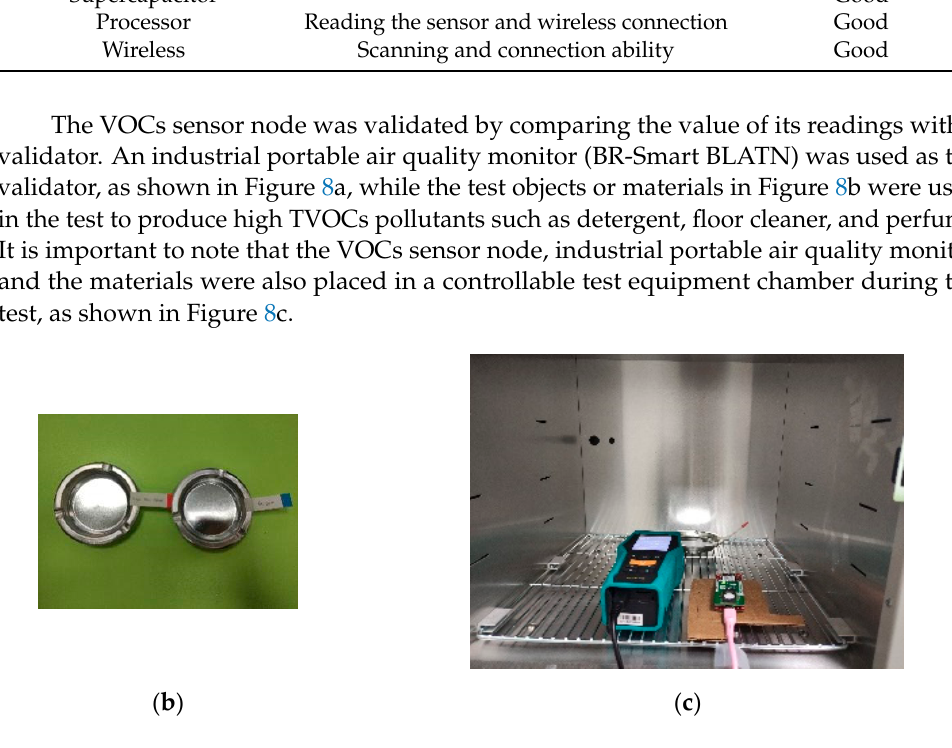
Figure 8. VOCs validation: ( a ) VOCs measurement instrument, ( b ) test object, and ( c ) test configu- ration.